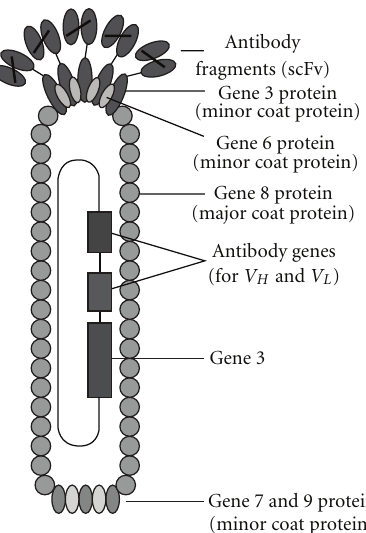
Figure 2: Structure of a filamentous phage displaying scFv frag- ments on its surface